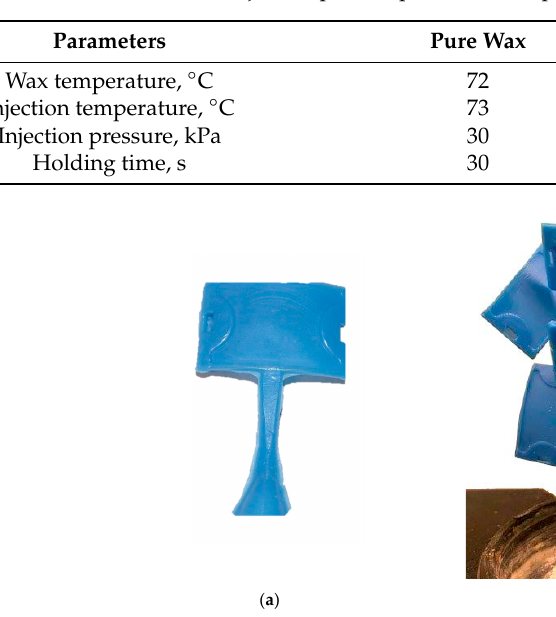
Figure 5. PE-wax/0.4 bentonite (BNT) system: ( a ) wax pattern, ( b ) pattern assembled on a “tree.”